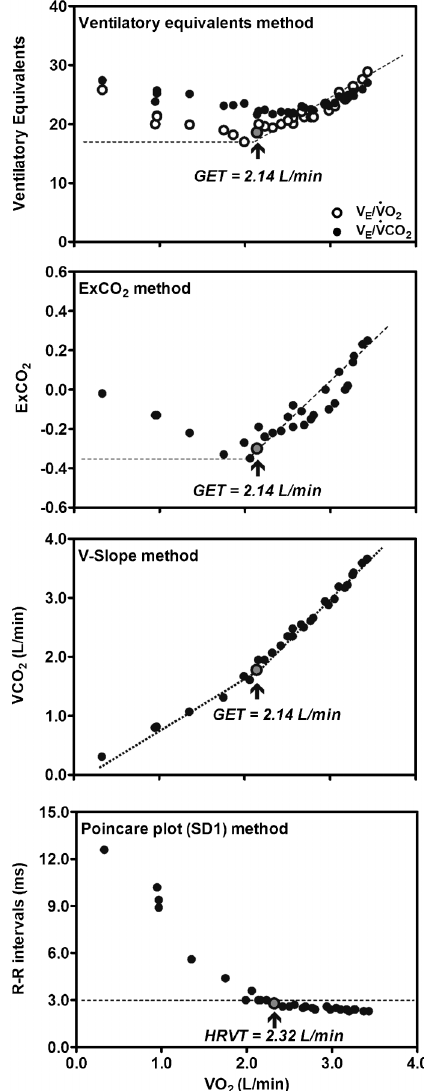
Figure 1. Graphic illustration of the methods used to determine the gas exchange threshold (GET; ventilatory equivalents method, excess CO 2 method, V-slope method) and heart rate variability threshold (HRVT; Poincare plot